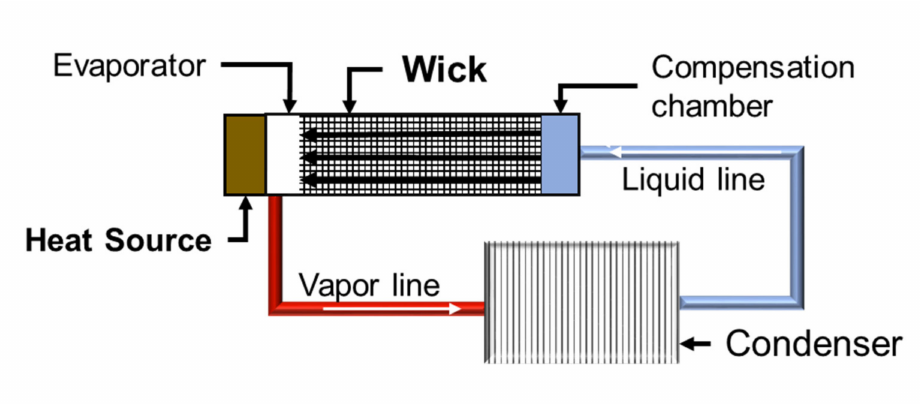
Figure 1. Schema of a loop heat